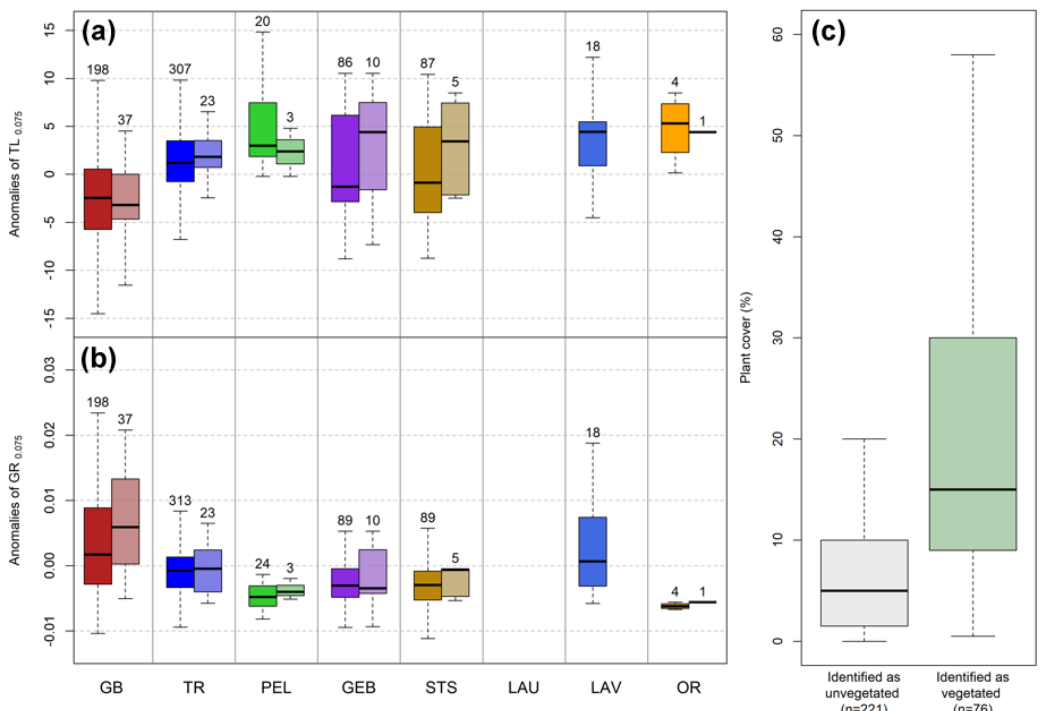
Figure 6. Distribution of (a) time lag and (b) growth rate anomalies for the eight glacier margins for an NDVI threshold of 0.075. For each glacier, the left boxplots with solid colors correspond to all pixels, while the right boxplots with more transparent colors correspond only to pixels overlapping floristic plots. (c) Distribution of plant cover (%) for floristic plots that have been identified as vegetated or unvegetated based on the remote sensing